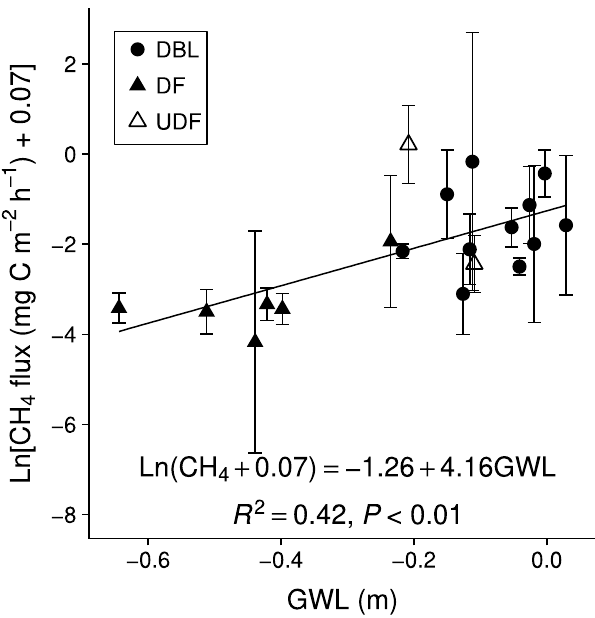
Figure 4 . Relationship between log-transformed CH 4 flux and groundwater level (GWL) in DBL (drained burned land), DF (drained forest), and UDF (undrained forest). Error bars show ±1 SD. Line shows the result of regression (Table 3).